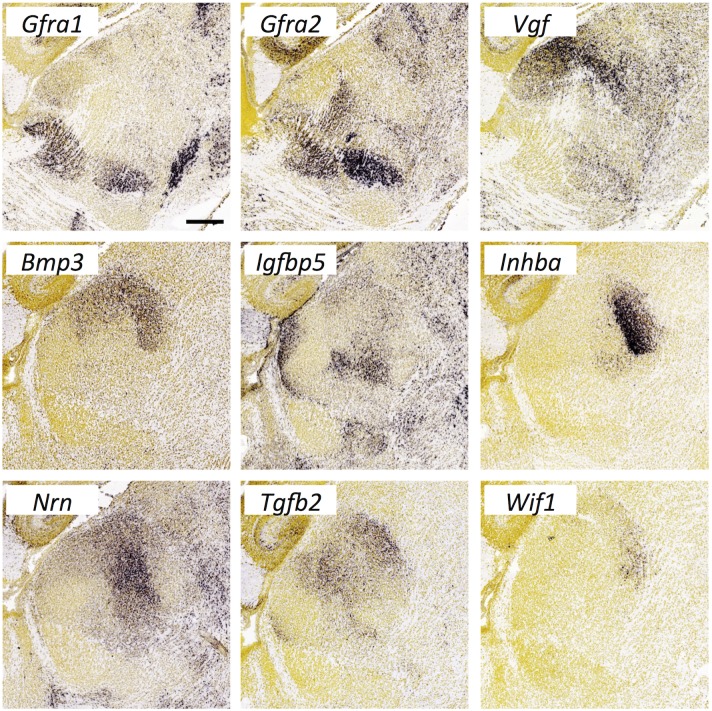
Expression of growth factors and receptors in the thalamus at E18.5.In situ hybridization data from sagittal sections of the thalamus at E18.5 obtained from the devABA revealed differential patterns of expression of Gfra1 and Gfra2 (GDNF Family Receptor Alpha 1 and 2), Vgf (VGF nerve growth factor inducible), Bmp3 (Bone morphogenetic protein-3), Igfbp5 (Insulin-like growth factor binding protein 5), Inhba (Inhibin/Activin, beta A subunit), Nrn (Neuritin or Neuritin-1/Nrn1), Tgfb2 (Transforming growth factor, beta 2) and Wif1 (WNT inhibitory factor 1). See text for details. A representative section is shown for each gene (see S8 Fig for details on how the sections were selected). Gfra1, Gfra2 and Vgf expression is shown laterally, while the other gene expression patterns are shown medially. Scale bar in Gfra1: 299 μm.